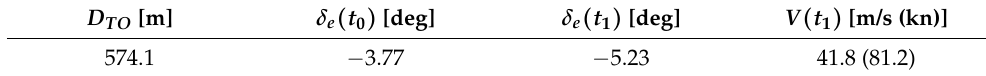
Table 3. Optimal parameters for best take-off maneuver, for the two-surface baseline aircraft.